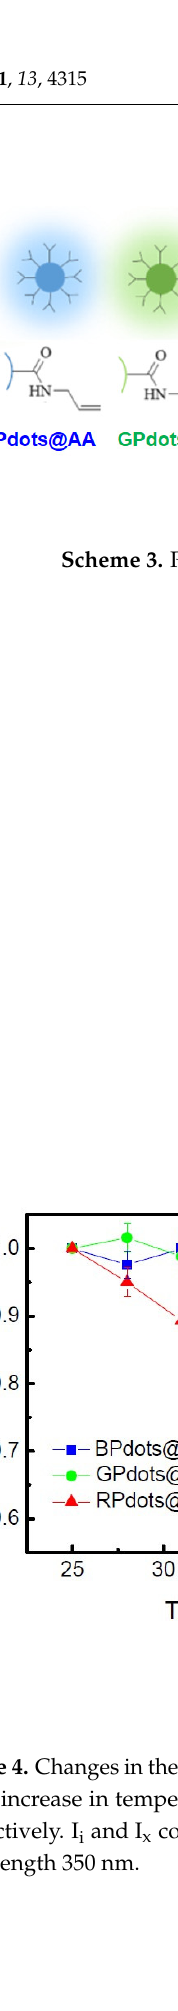
Figure 5. Changes in the ( a ) hydrodynamic diameters and ( b ) relative fluorescence intensities (I x /I i ) of BPdots@PNIPAM ( ■ ), GPdots@PNAIPAM ( ● ), and RPdots@PNAIPAM ( ▲ ) in aqueous solution over repeated heating (45 °C) and cooling